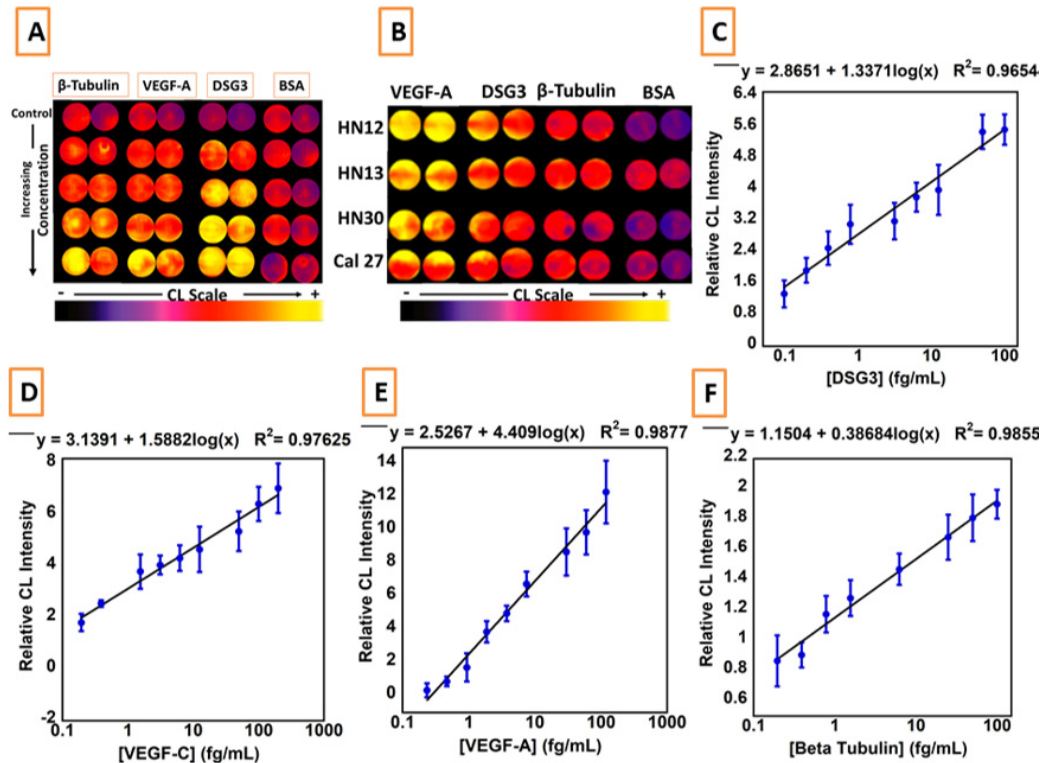
Figure 8. Recolorized CL CCD camera for 15 s integration for protein analytes in ( A ) standards and ( B ) cancer cell cultures. ( D – F ) Calibrations of the microfluidic immunoarray for ( C ) DSG3, ( D ) VEGF-C, ( E ) VEGF-A, and ( F ) β -Tub (n = 8). Adapted from [43], with permission. Copyright Elsevier,